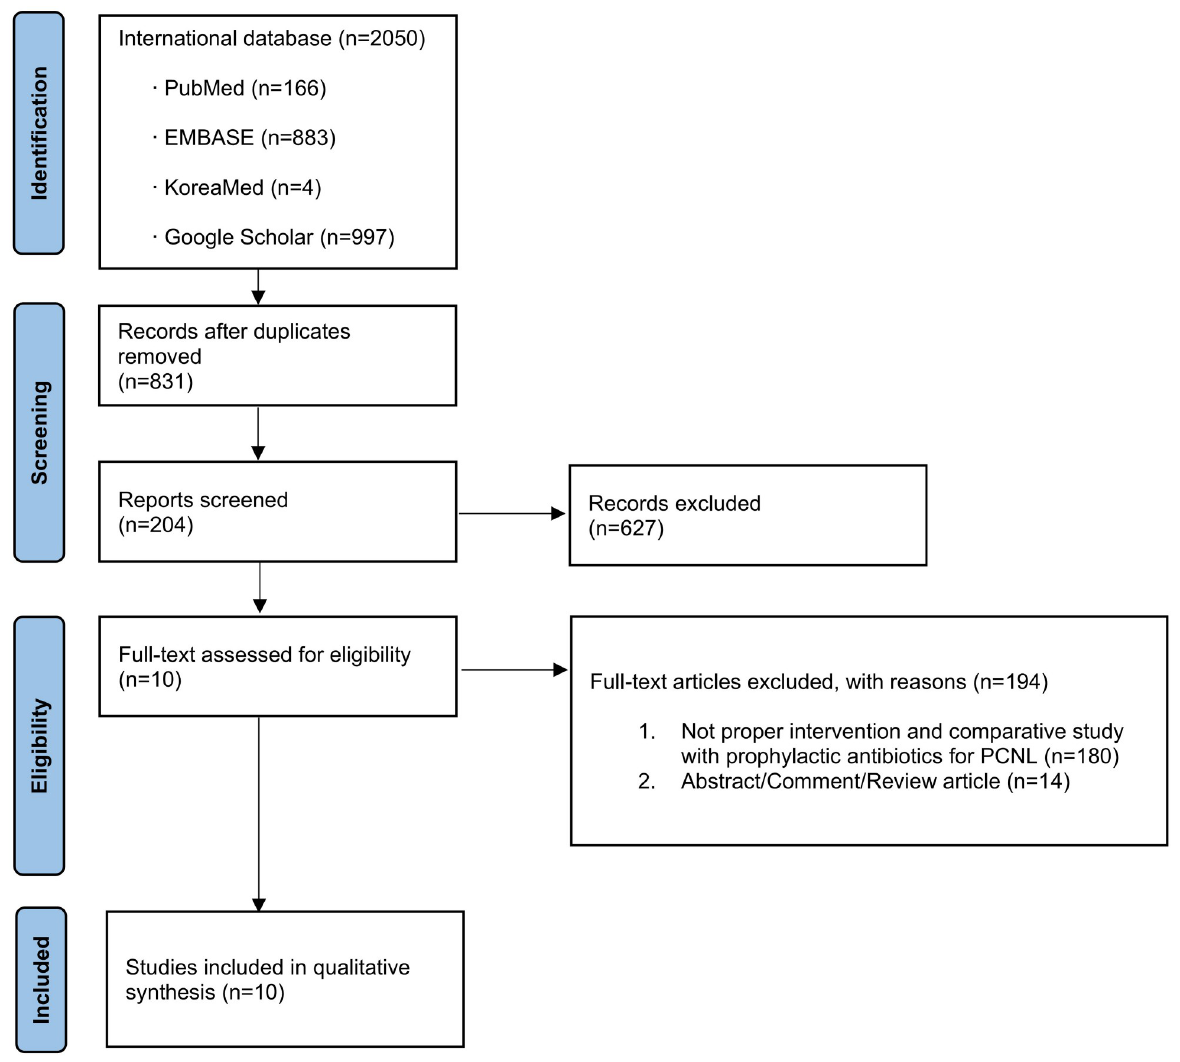
Fig 1. Study flow